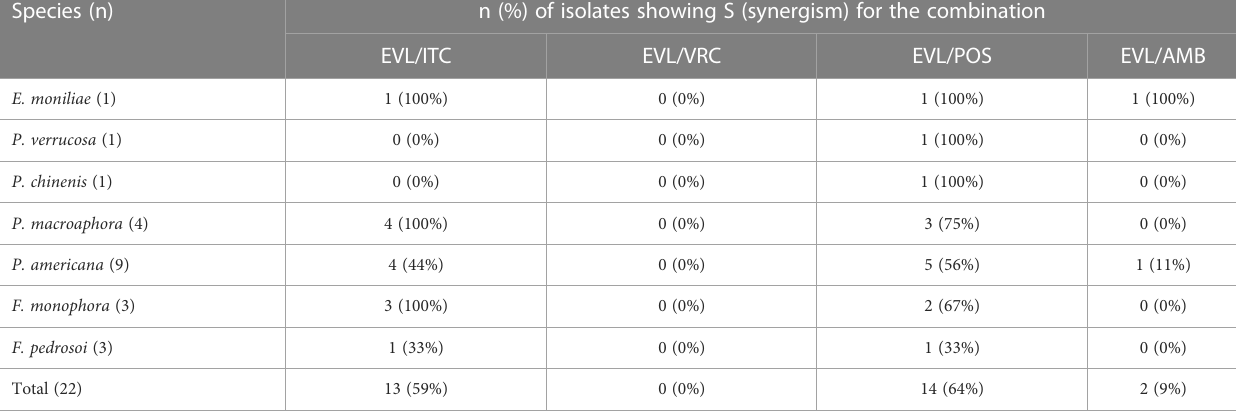
TABLE 2 In vitro drug interactions summary.